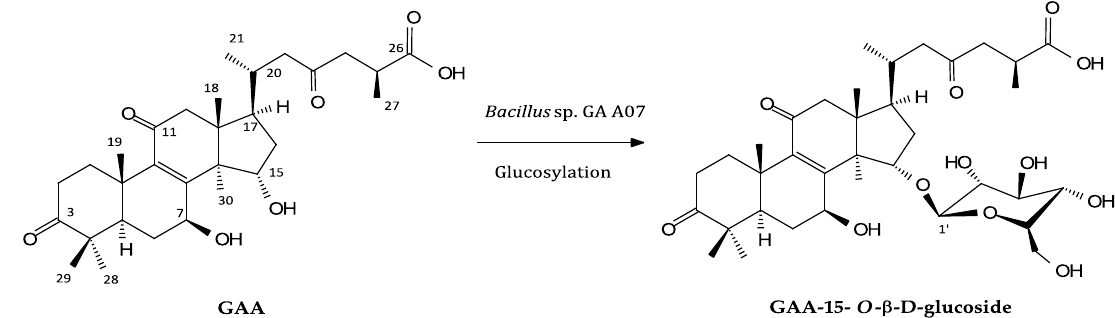
Figure 3. Biotransformation process of GAA using the Bacillus sp. GA A07 strain.